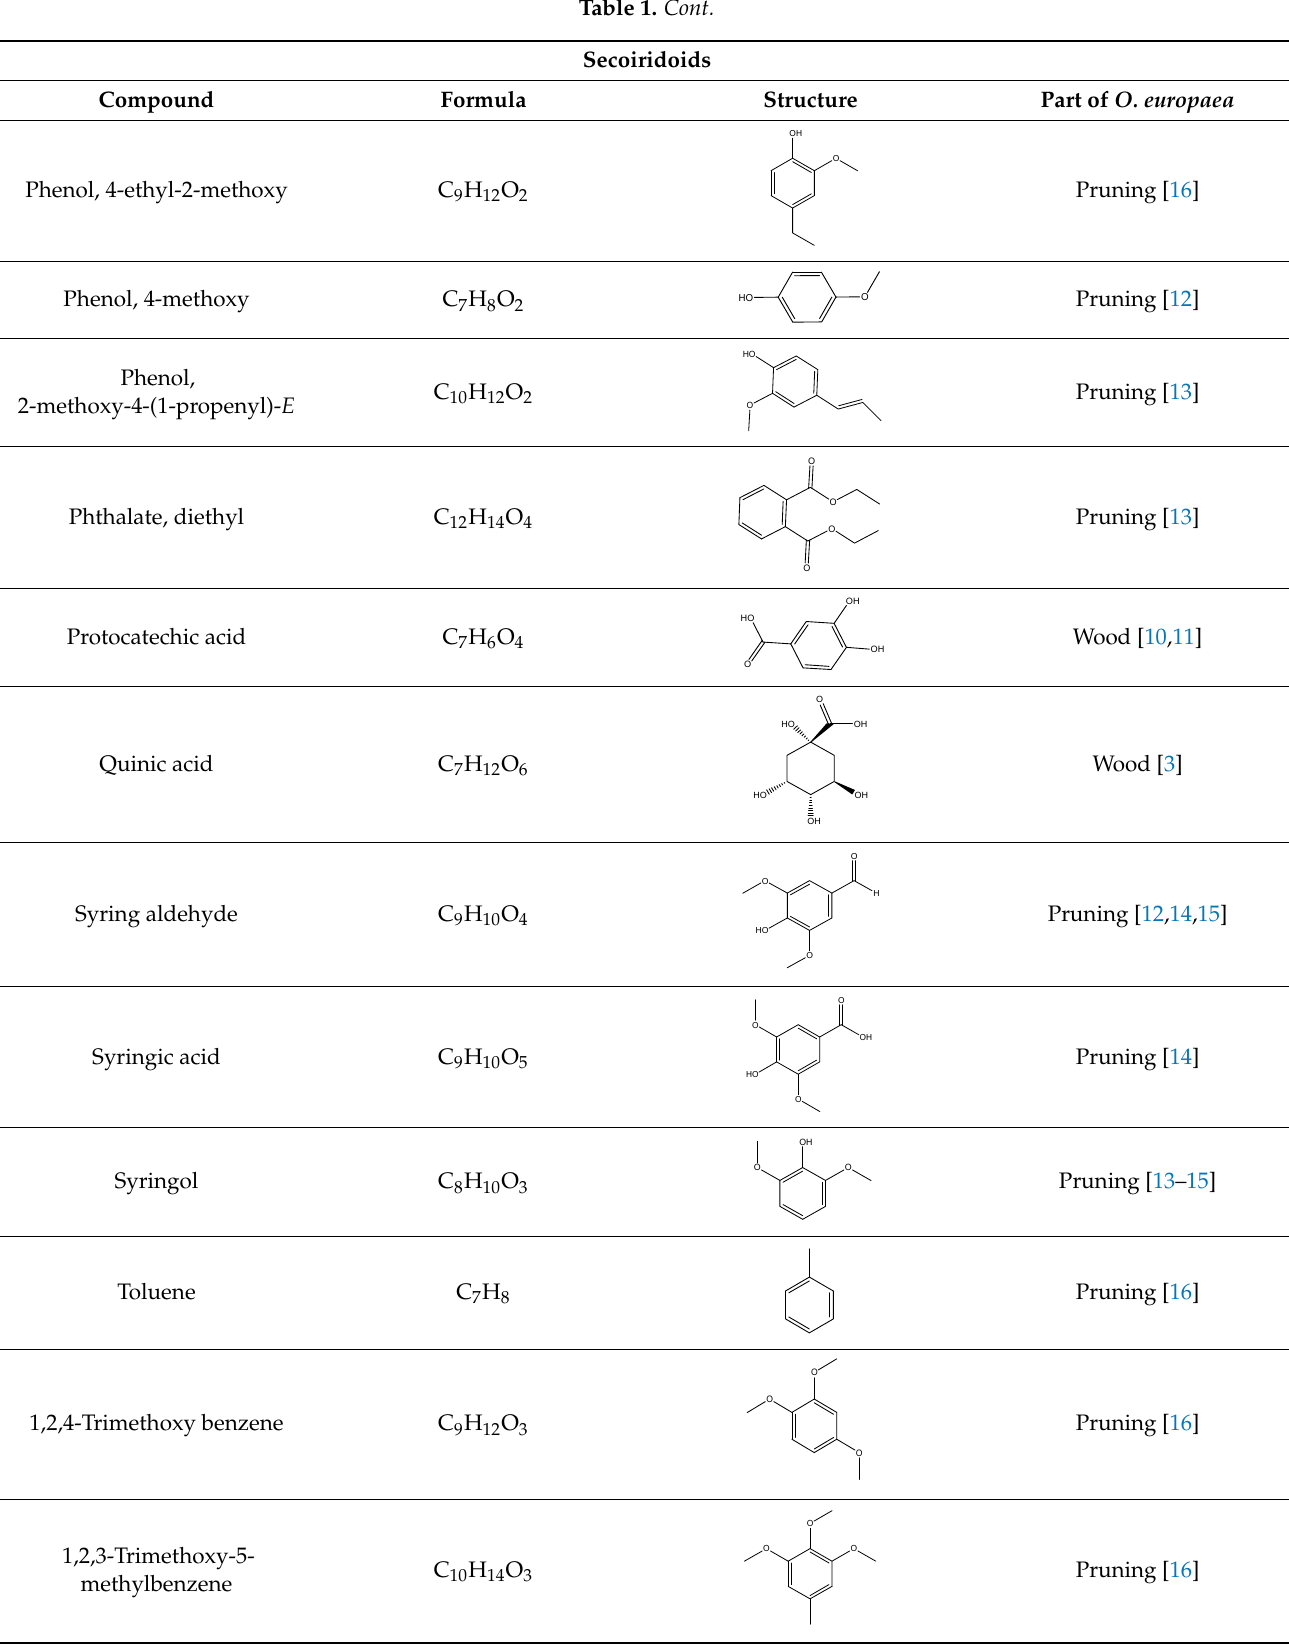
Table 1. Cont. Secoiridoids